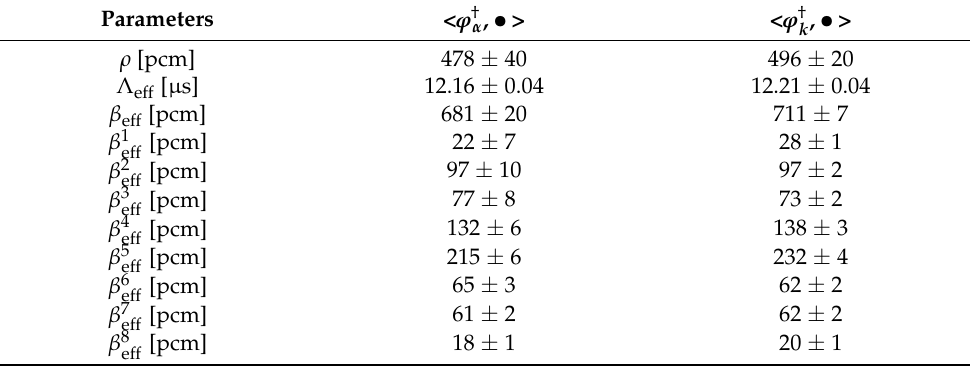
Table 14. Effective kinetics parameters of Problem III, super-critical configuration including delayed